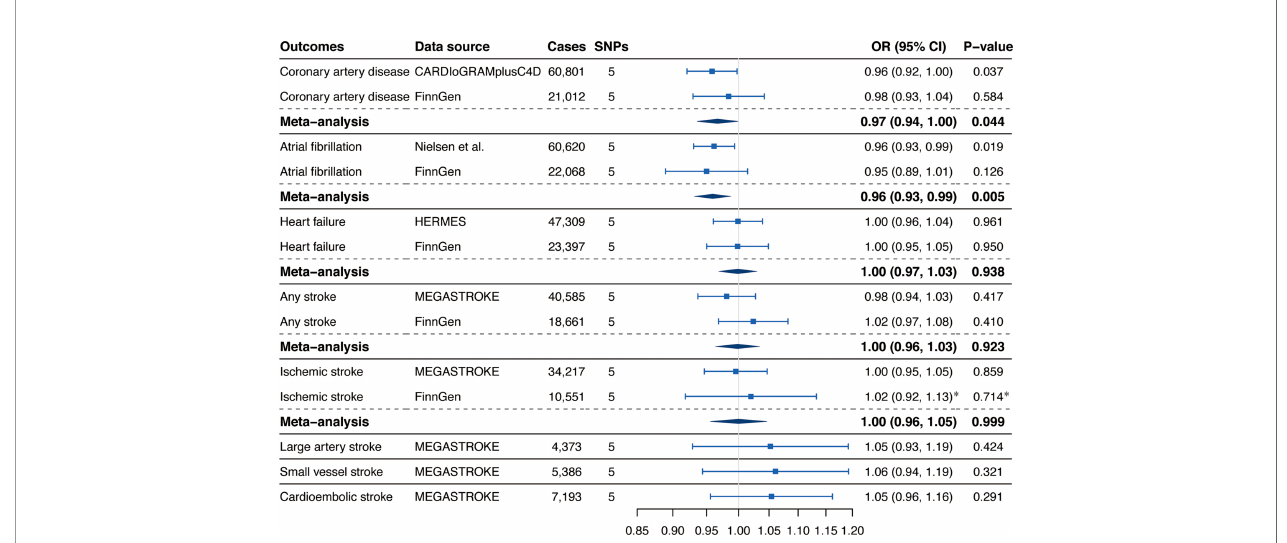
FIGURE 2 | Associations of genetically predicted circulating a -Klotho levels with cardiovascular diseases. SNPs, single-nucleotide polymorphisms; OR, odds ratio; CI, con fi dence interval; CARDIoGRAMplusC4D, Coronary ARtery DIsease Genome-wide Replication and Meta-analysis (CARDIoGRAM) plus The Coronary Artery